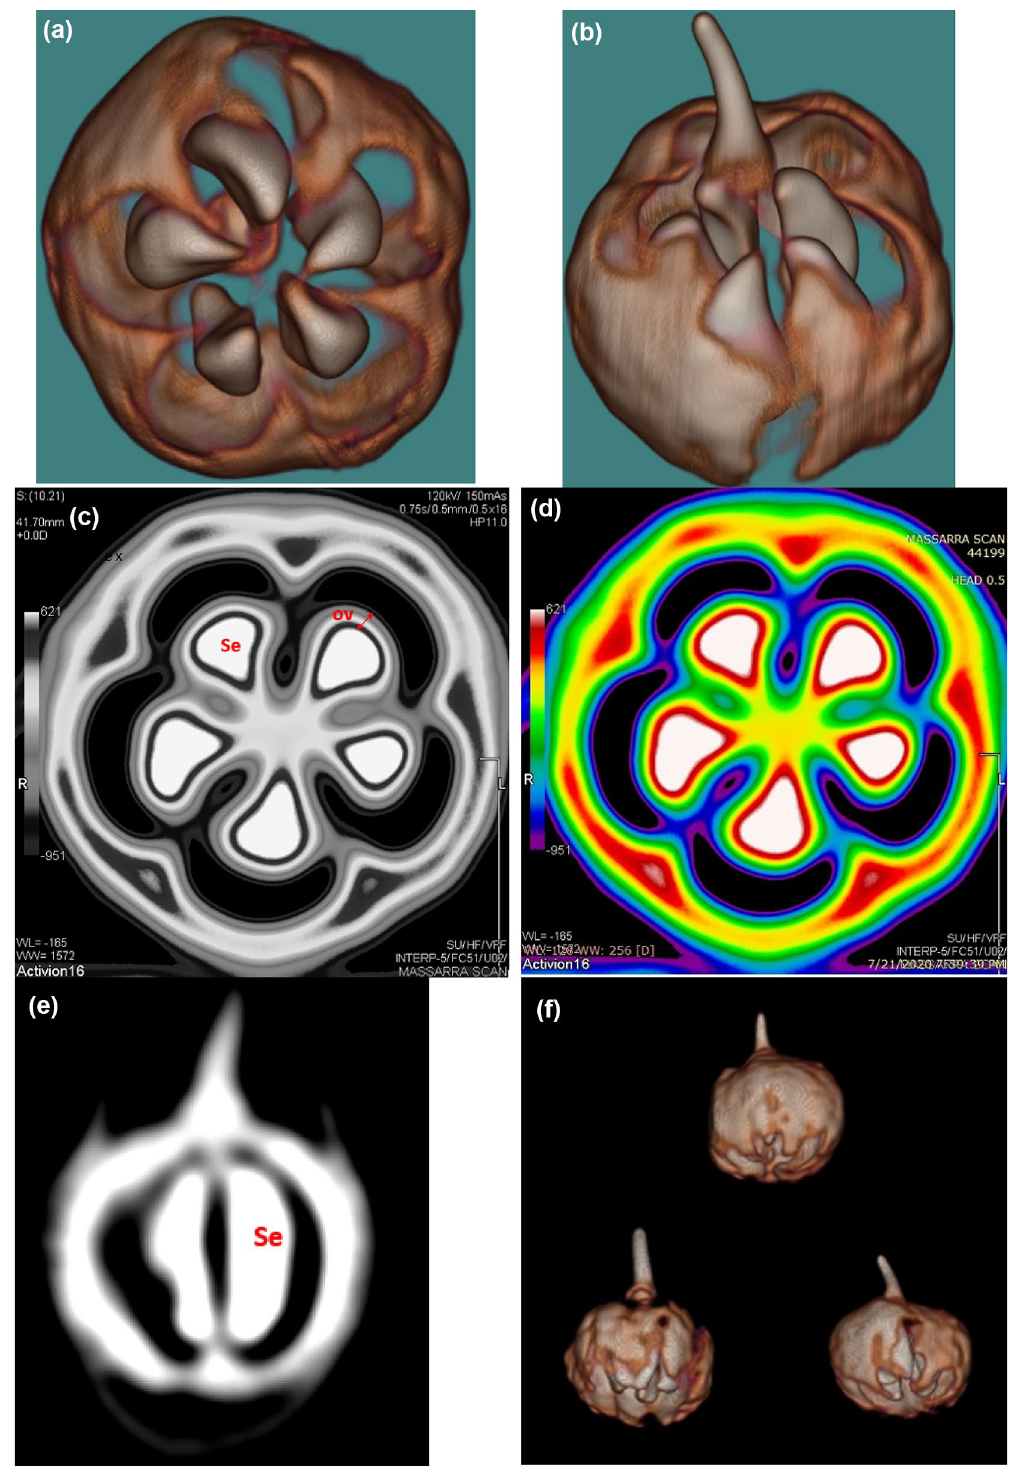
Figure 4. CT scanning of the modern fruit specimen; top view ( a ) and side view ( b ), transverse sections in the endocarp ( c , d ) Ov ovules; longitudinal section ( Se seed) ( e ), and the shape and form of the whole cone ( f